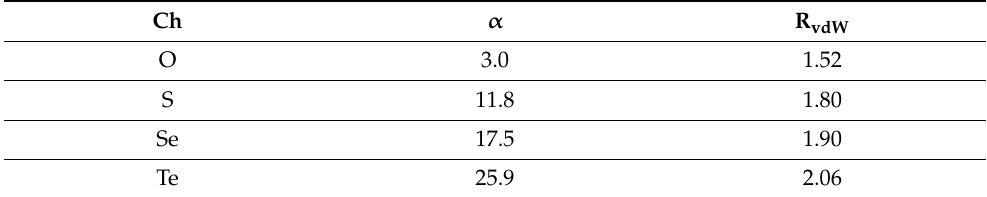
Table 1. Atomic polarizabilities ( α , a.u.) calculated at the MP2/def2-TZVP level of theory of chalcogen (Ch) elements and their van der Waals radii (R vdW , Å). Ch